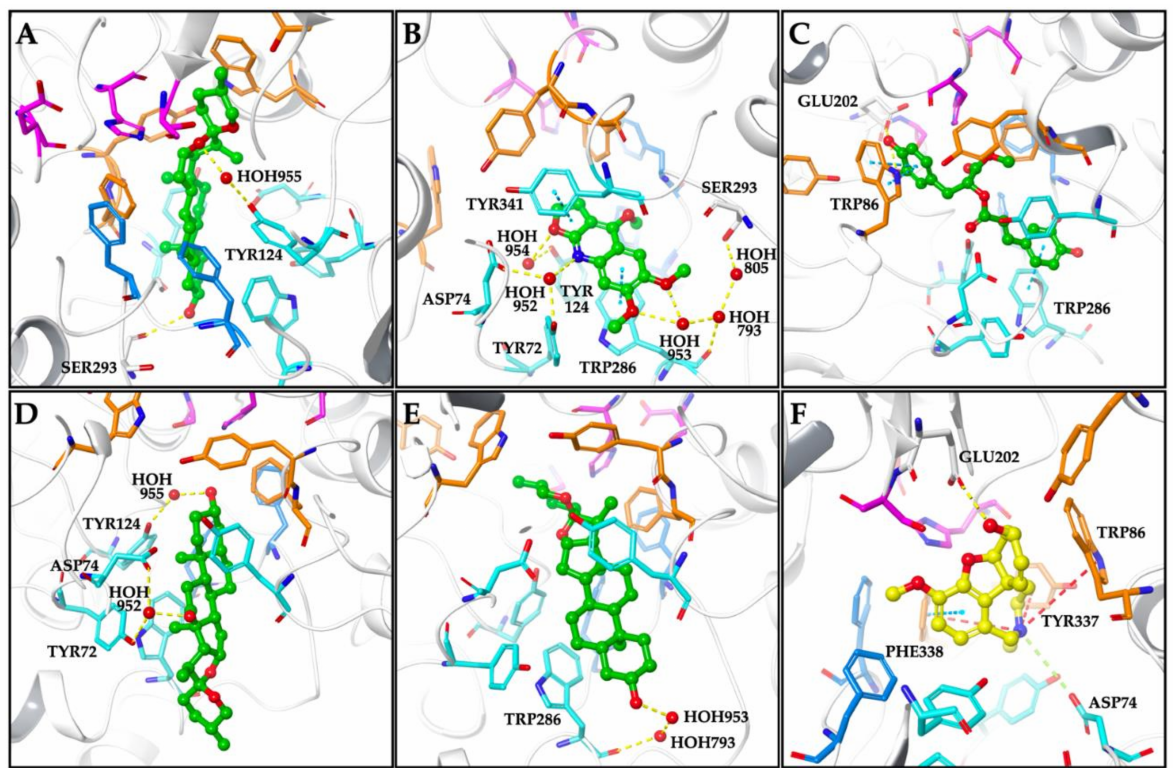
Figure 2. Proposed binding modes for smilagenin ( A ), kokusaginine ( B ), methyl rosmarinate ( C ), hecogenin ( D ), tigogenin ( E ), and galanthamine ( F ) in the hAChE active site (PDB: 4EY7). The compounds are presented as green and yellow ball and stick models. The regions comprising the residues are colored as follows; catalytic triad: magenta, oxyanion hole: orange, acyl binding site: blue, peripheral anionic site: cyan. Hydrogen bonds, π - π stacking contacts, π -cation contacts, and salt bridge are represented by yellow-, cyan-, red-, and green-dashed lines,